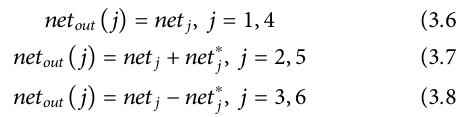
FIGURE 7 | Steering wheel